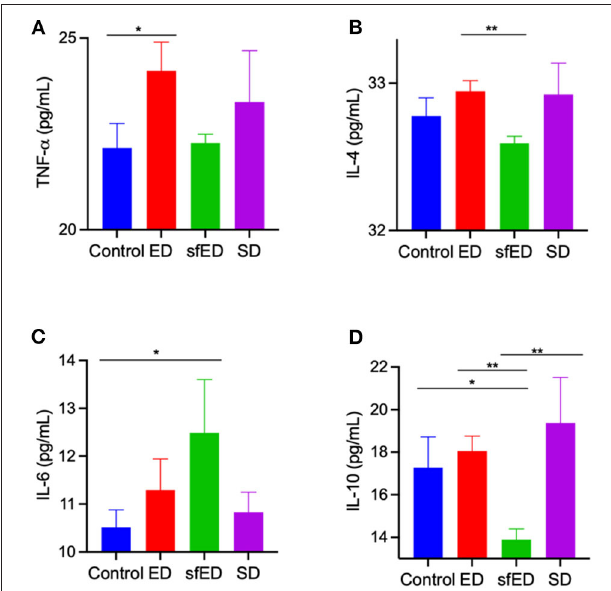
FIGURE 4 | Serum cytokine concentrations. The mice received Mother (ED), sugar-free Mother (sfED), Coca-Cola (SD), or water (control) for 13 weeks. Serum concentrations of inflammatory cytokines, TNF- α (A) , IL-4 (B) , IL-6 (C) , and IL-10 (D) were measured using the flow cytometry beads array. Statistical analysis was performed Kruskal-Wallis test with uncorrected Dunn’s post-hoc analysis ( n = 10; * p < 0.05, ** p <